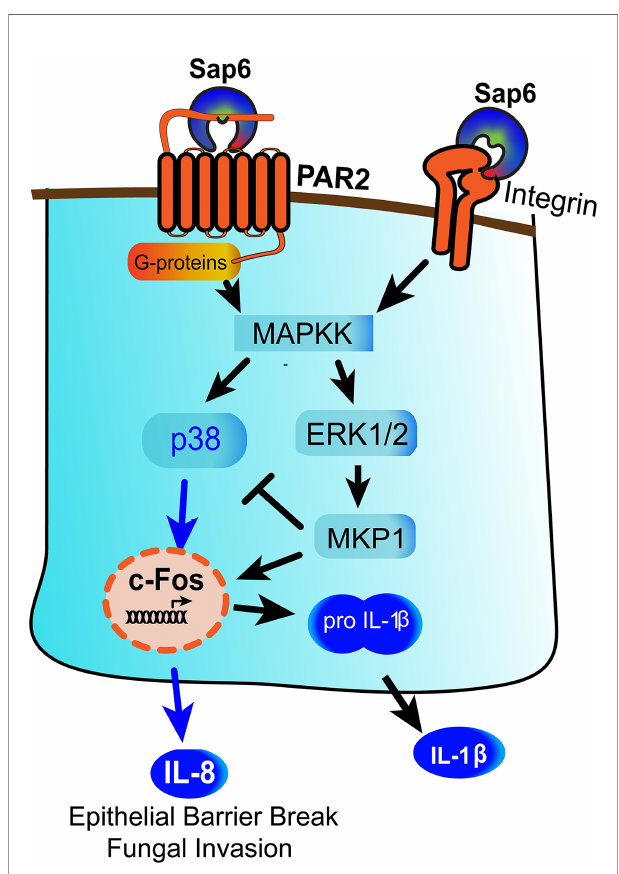
FIGURE 7 | Model for Sap6 mediated oral epithelial cells activation and cytokine release. Sap6 can interact with host cells via cell surface receptors including PAR2 or integrins to induce cytokine release through independent pathways. Sap6 protease activity initiates PAR2 signaling by p38 phosphorylation and release of IL-8, while Sap6 RGD domain binds surface integrins to initiate signaling via MKP1 to induce IL-1 b release. Sap6 mediated PAR2 signaling contributes to loss of epithelial barrier function and increased fungal